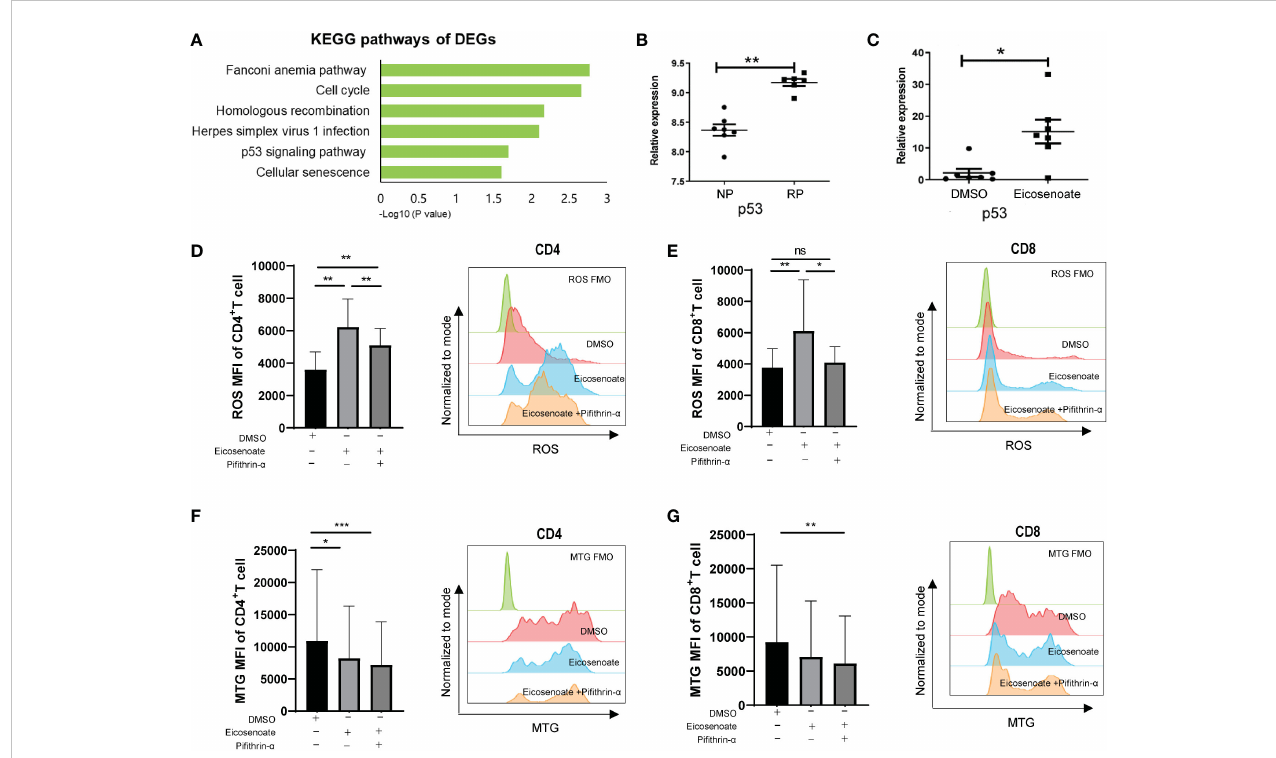
FIGURE 4 The p53 pathway participates in eicosenoate-induced impairment of T-cell mitochondrion function. (A) The top six signaling pathways enriched in 2,317 differentially expressed genes (DEGs) obtained from the analysis of previous transcriptome data (GSE44216) from rapid progressors (RPs) and normal progressors (NPs; adjusted P < 0.05). (B) p53 mRNA expression in PBMCs (GSE44216) was signi fi cantly increased in RPs (n = 6) compared with NPs (n = 7) ( P < 0.01). (C) p53 mRNA expression in CD3 + T cells was signi fi cantly increased after co-incubation with 500 m M eicosenoate and anti-CD3/CD28-coated Dynabeads (4:1 ratio) for 48 h in vitro (n = 7) ( P < 0.05). p53 expression was quanti fi ed and normalized to that of GAPDH and expressed using the relative quanti fi cation method (2 − DD Ct ). (D) Primary CD3 + T cells were stimulated with anti-CD3/CD28-coated Dynabeads (4:1 ratio) and 500 m M eicosenoate with or without 20 m M p53 inhibitor pi fi thrin- a and incubated for 24 h, and mitochondrial ROS was detected. The p53 inhibitor pi fi thrin- a partially reduced the increase in ROS induced by eicosenoate in CD4 + T cells (n = 8). (E) The p53 inhibitor pi fi thrin- a prevented the increase in ROS induced by eicosenoate in CD8 + T cells to control levels (n = 8). (F) The eicosenoate-induced reduction in mitochondrial mass in CD4 + T cells was not restored by treatment with the p53 inhibitor pi fi thrin- a (n = 11). (G) The eicosenoate-induced reduction in mitochondrial mass in CD8 + T cells was not restored by treatment with the p53 inhibitor pi fi thrin- a (n = 11). Representative fl ow cytograms are shown in each panel. * P < 0.05, ** P < 0.01, and *** P < 0.001. P values were calculated by Mann-Whitney test (B, C) , One-way ANOVA (D) , Friedman test (E – G) . ns, no signi fi